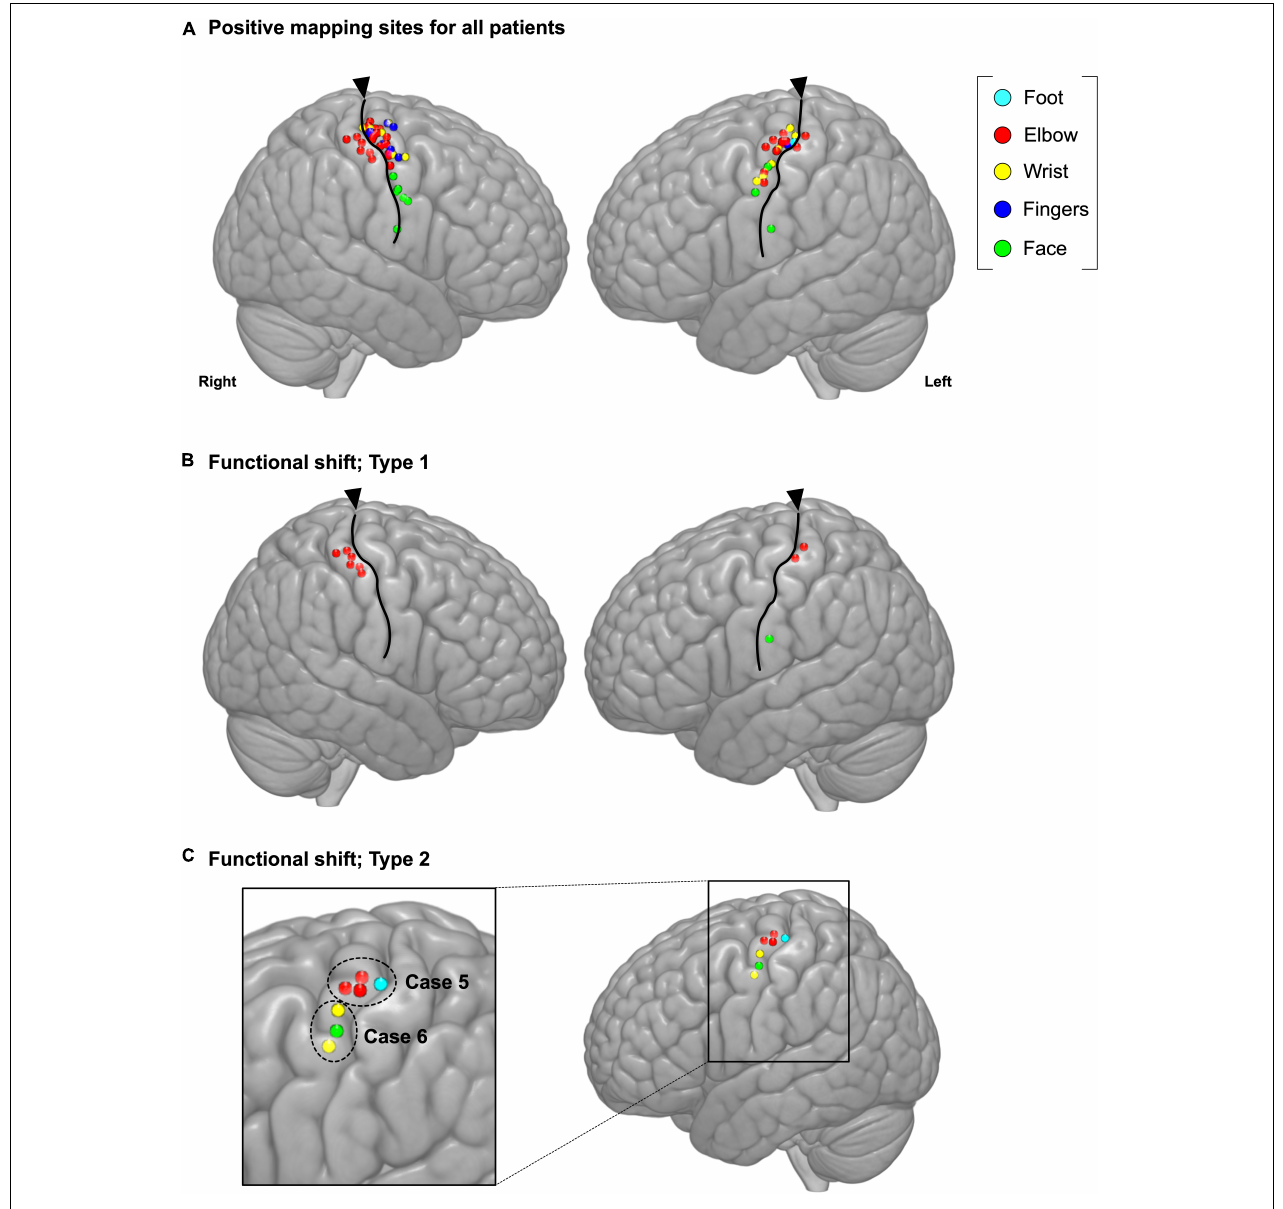
FIGURE 2 | Positive mapping of motor function sites during awake surgery. (A) The cerebral regions were directly stimulated during awake surgery to identify the motor area. When involuntary movement or dystonic movement was observed (positive mapping), these regions were defined as the motor area. We marked the location of positive mapping sites and body parts for which the symptoms were elicited. Upon analyzing the characteristics of the motor area’s functional shift, we identified two functional shift types: (B) Type 1 (move to ipsilateral different gyrus) and (C) Type 2 (move within the ipsilateral precentral gyrus). Cyan: foot; red: elbow; yellow: wrist; blue: fingers; green: face; triangles: location of central